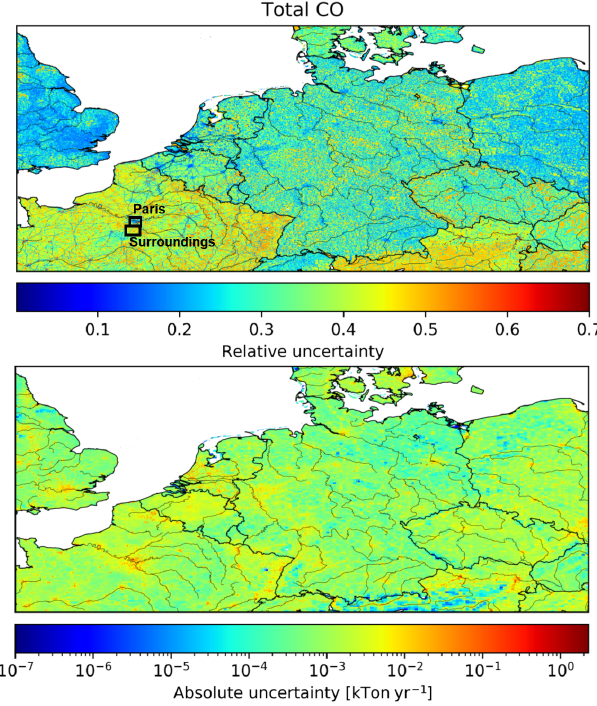
Figure 15. Maps of the relative and absolute uncertainty in CO emissions. Areas that are examined in more detail are outlined by black squares in the top